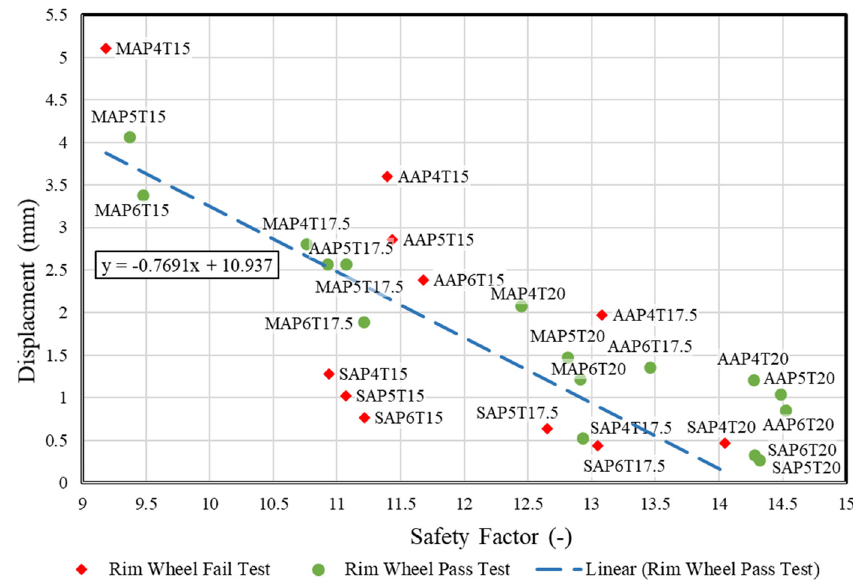
Figure 10: Response displacement due to the safety factor.